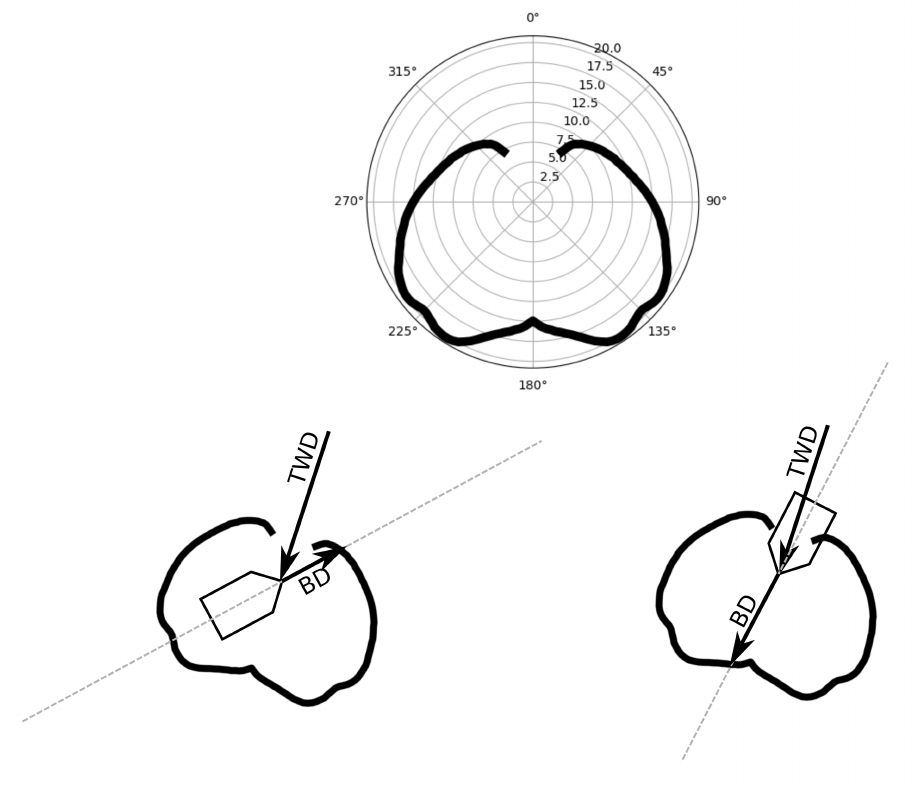
Figure 3. How to use a polar diagram slice to obtain the boat direction